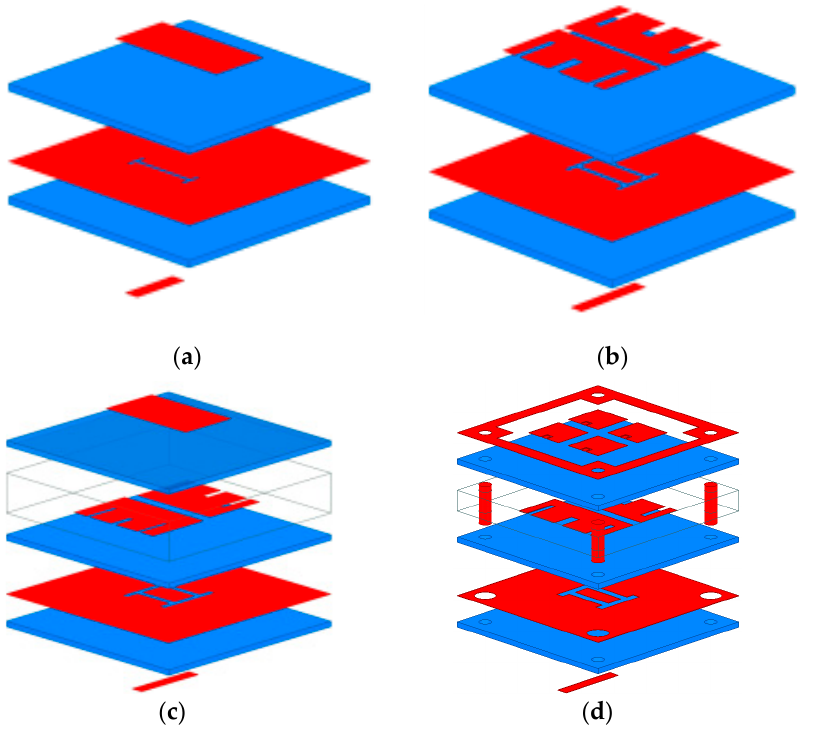
Figure 2. Design stages of the antenna element: ( a ) stage I, ( b ) stage II, ( c ) stage III, and ( d ) stage IV.